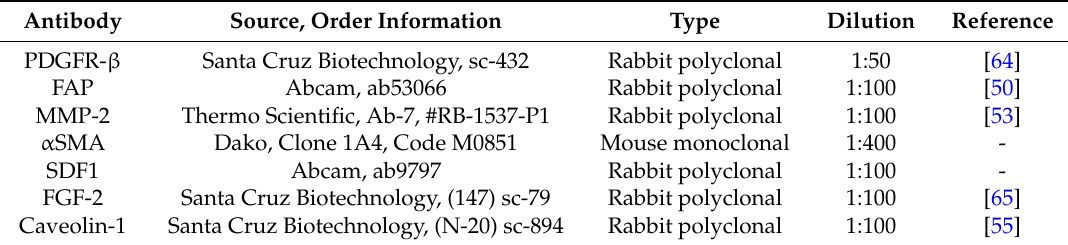
Table 5. Details of the primary antibodies used for